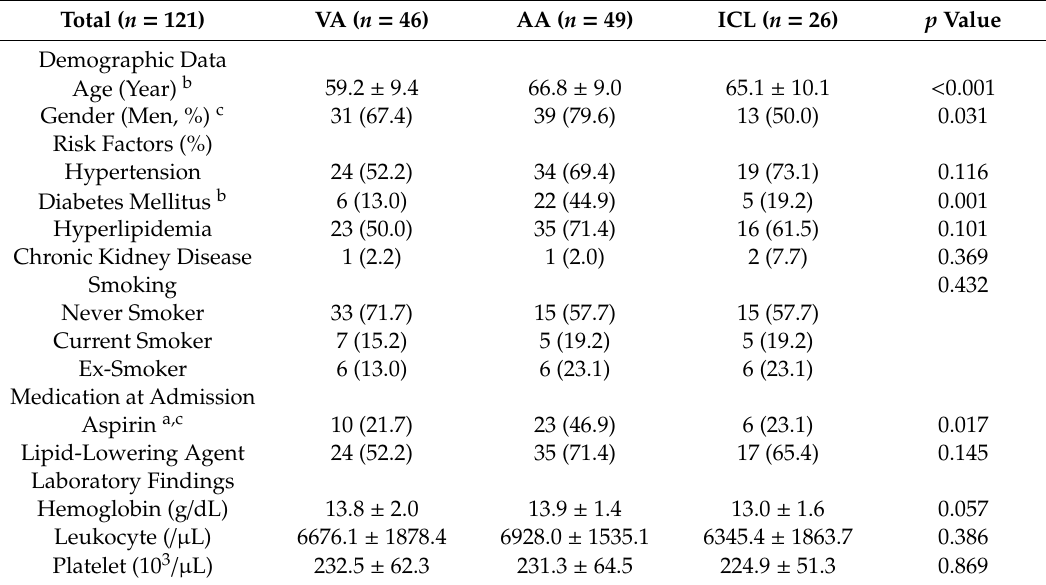
Table 1. Baseline characteristics stratified by final diagnosis after coronary